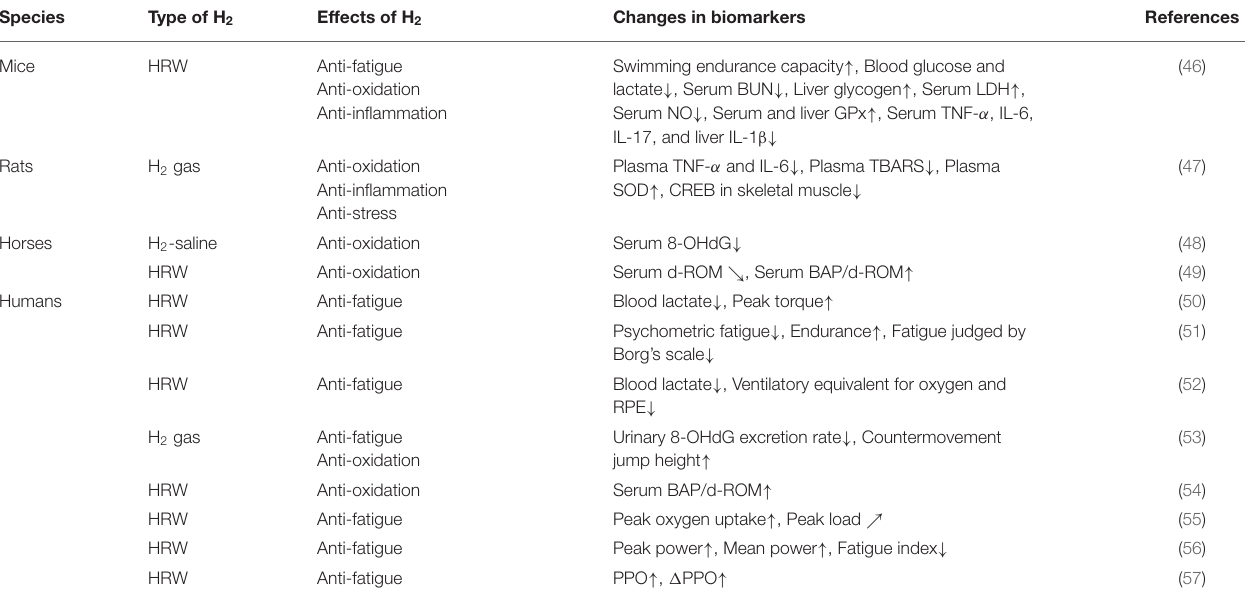
TABLE 1 | Summary of anti-fatigue effects of molecular hydrogen (H 2 ) in animal models and human clinical trials.